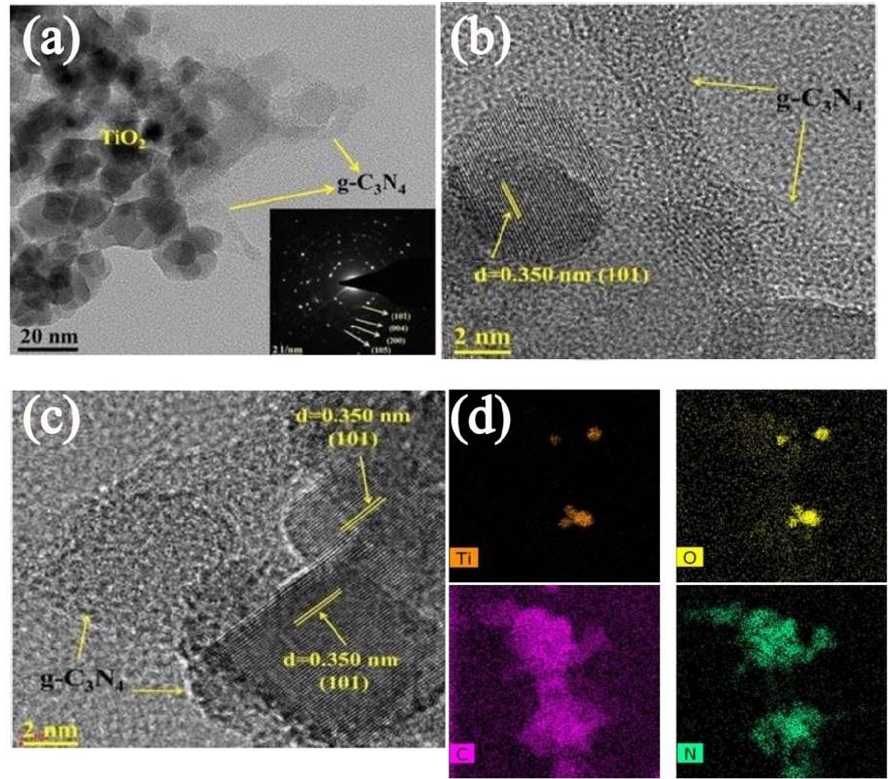
Figure 11. ( a ) TEM images of 5%-g-C 3 N 4 /TiO 2 nanoparticles (inset SAED pattern); ( b , c ) HRTEM images of 5%-g-C 3 N 4 ; ( d ) elemental mapping image of Ti, O, C, N elements of the 10%-g-C 3 N 4 /TiO 2 composite, Copyright © 2022 Elsevier [144].